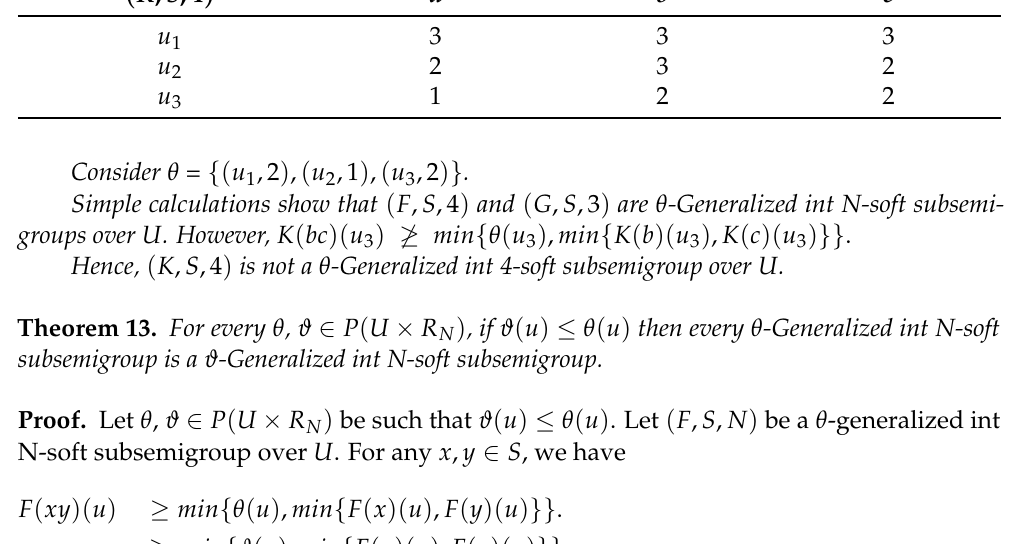
Table 17. The 4-Soft Set of ( K , S ,4 ) . ( K , S , 4 )